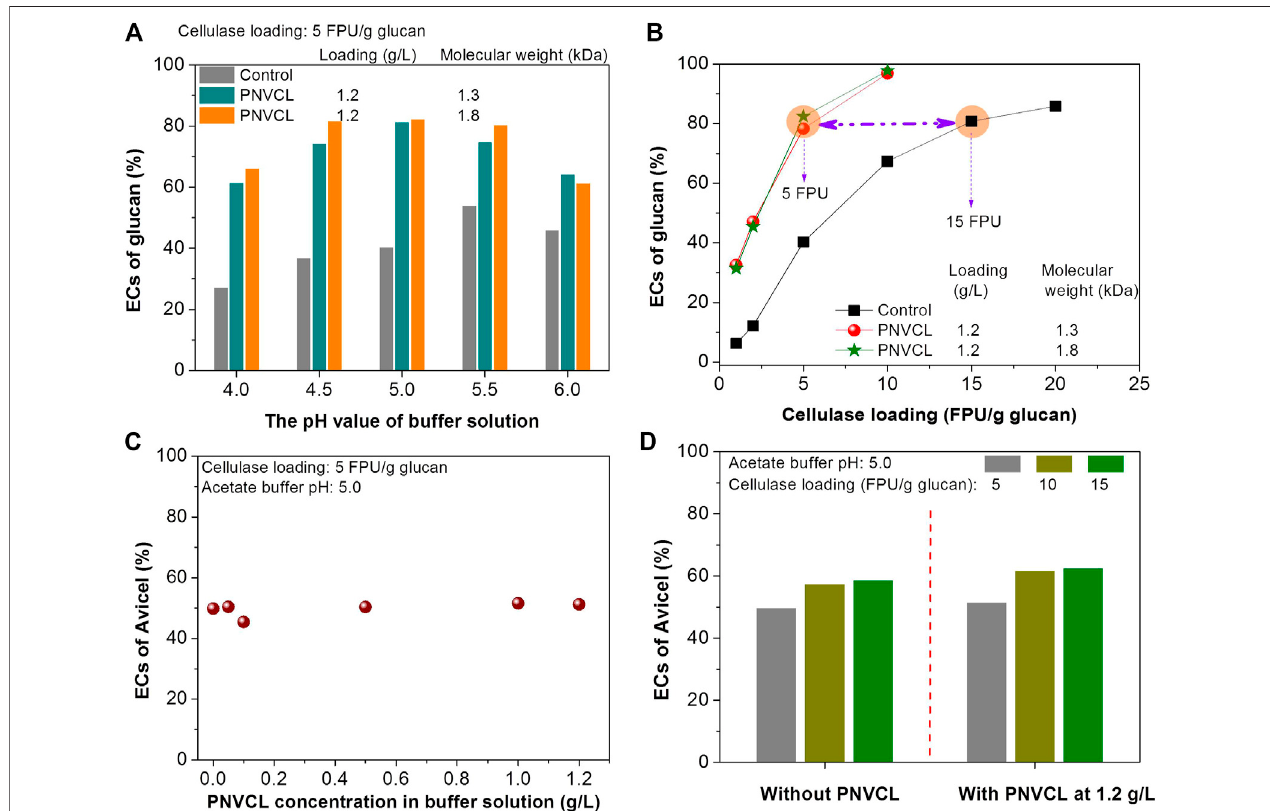
FIGURE 5 | Effects of (A) the pH values of acetate buffer solutions and (B) cellulase loadings on the ECs of glucan in PSA-Ba substrate; effects of (C) and (D) PNVCL loading on the ECs of Avicel at different cellulase dosage (5 – 15 FPU/g glucan). The pH values of acetate buffer solution used in Figure 5B are 5, and the β -glucosidase loading (CUB/g glucan) for each enzymatic hydrolysis is 1.5 times of cellulase loading (FPU/g